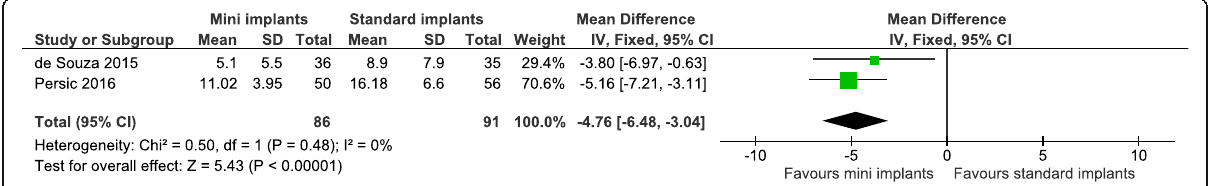
Fig. 3 Forest plot of quality of life. A statistically significant improvement was observed in the quality of life parameter with mini implants than standard